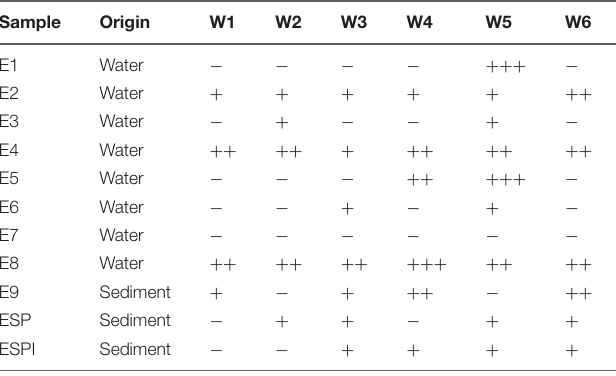
TABLE 1 | Drop collapse test results for each